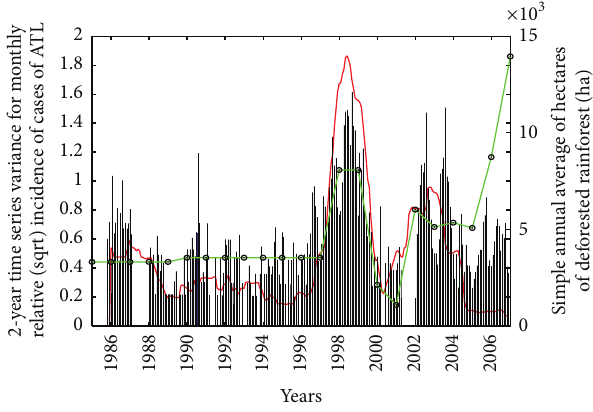
Figure 9: The 2-year variance times series for relative (sqrt) incidence of American Tegumentary Leishmaniasis cases (red line) and linear piecewise function 𝑓 𝐷 (𝑡) for annual average deforestation (green line) in Departament of Or´an, Salta, Argentina, period 1985–